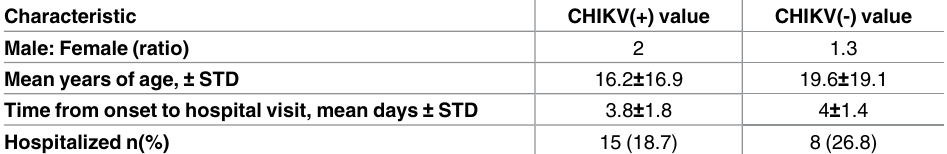
Table 2. Demographic data for CHIKF(+) and CHIKF(-) patient serum samples collected from patients in La Romana, Dominican Republic July-August 2014, and associated relative